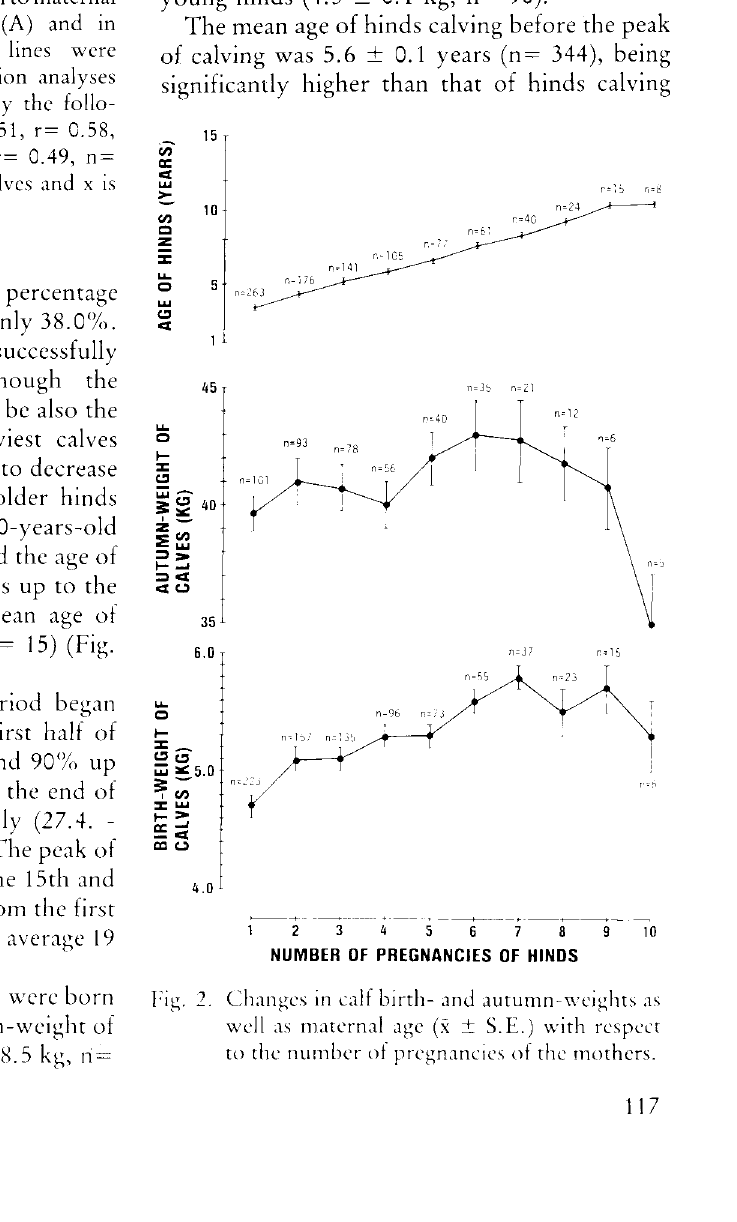
Fig. 1. Mean calf birth-weights in relation to maternal weights just prior to calving (A) and in preceeding autumn (B). The lines were obtained by polynomial regression analyses and are described respectively by the follo wing equations: y= 0.072x -I- 0.51, r= 0.58, n= 70 and y= 0.054x + 1.42, r= 0.49, n = 649, where y is the weight of calves and x is the weight of